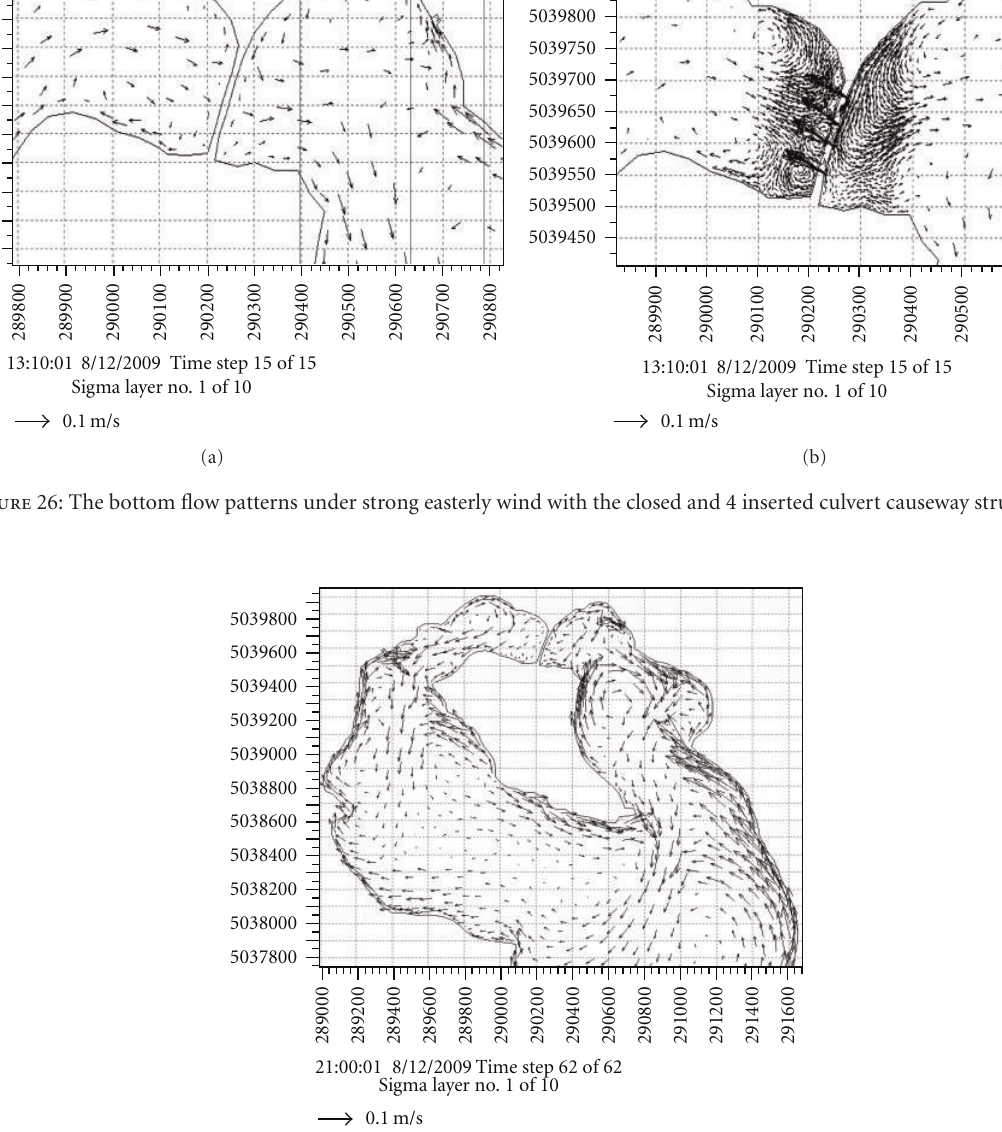
Figure 27: The bottom flow from the causeway shallow region to deep water and from the east side to west side of the island induced by 7m/s constant south-west